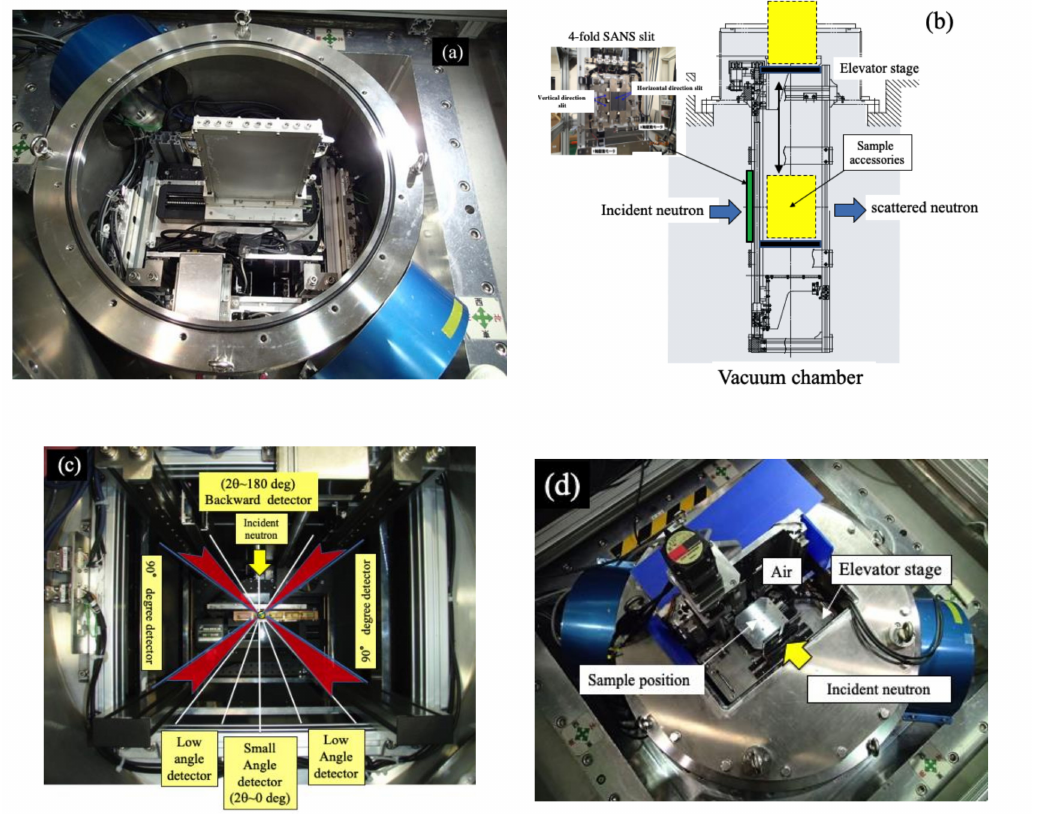
Figure 7. iMATERIA’s sample stage: ( a ) photo of in-vacuum components; ( b ) schematic diagram; ( c ) top view; ( d ) photo of top flange and components in air.